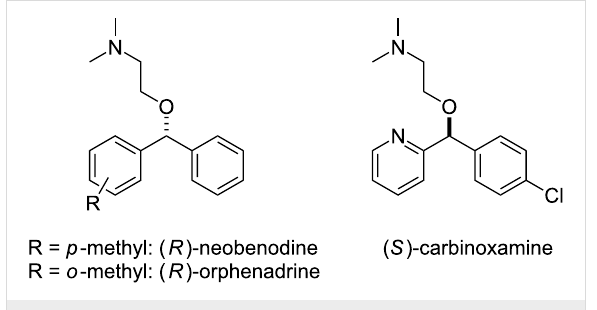
Figure 1: Biologically active diarylmethanol